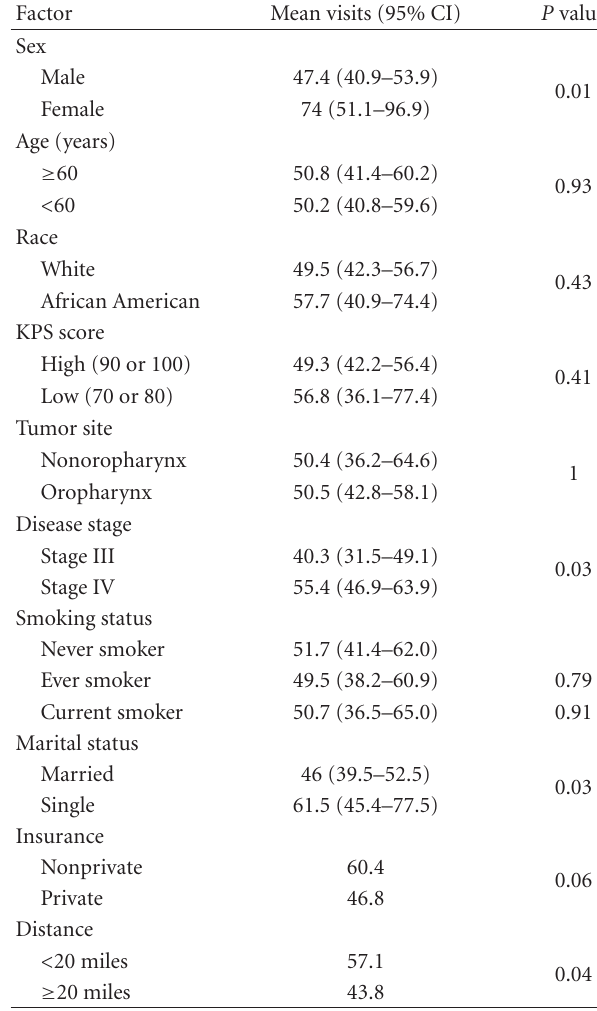
Table 5: Speech and swallowing: simple linear regression model. Table 6: Combined services: simple linear regression model.